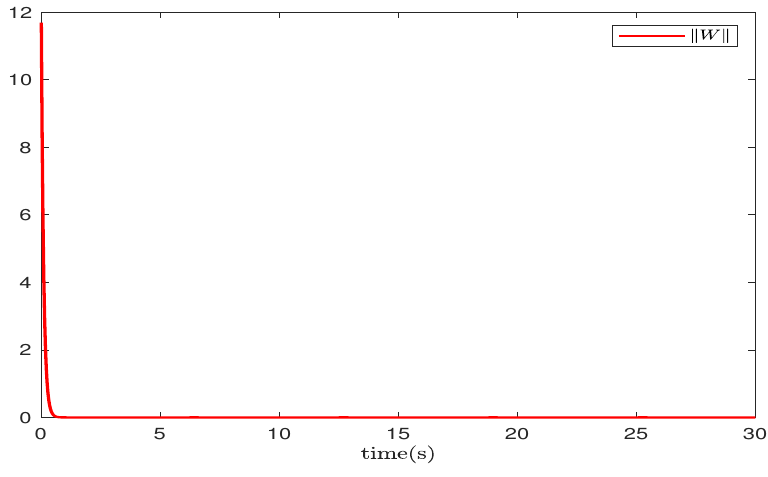
Figure 6. The norm of ˆ W